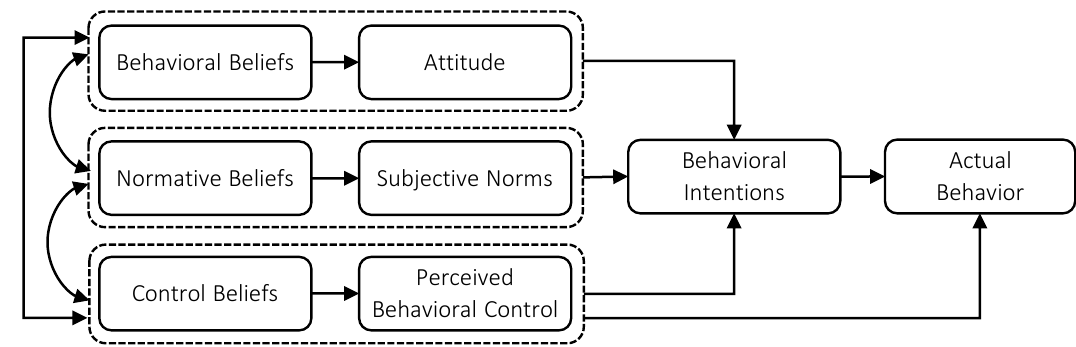
Figure 1. Theory of planned behavior